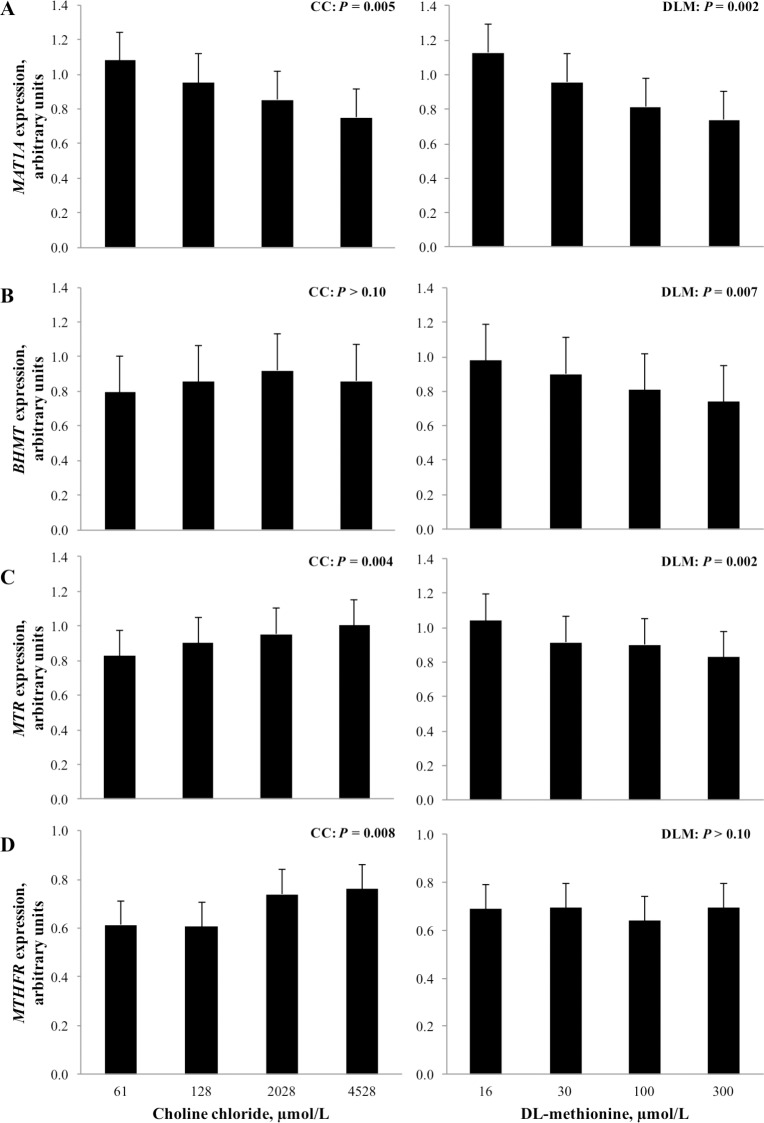
Expression of genes related to choline and methionine metabolism in the transmethylation pathway in neonatal bovine hepatocytes exposed to increasing concentrations of choline chloride (CC) and DL-methionine (DLM).The P-values for linear effects of CC and DLM are shown; there were no interactions between CC and DLM. Values are least squares means, with SE represented by vertical bars. Methionine adenosyltransferase 1A (MAT1A), betaine-homocysteine S-methyltranferase (BHMT), 5-methyltetrahydrofolate-homocysteine methyltransferase (MTR), methylenetetrahydrofolate reductase (MTHFR).